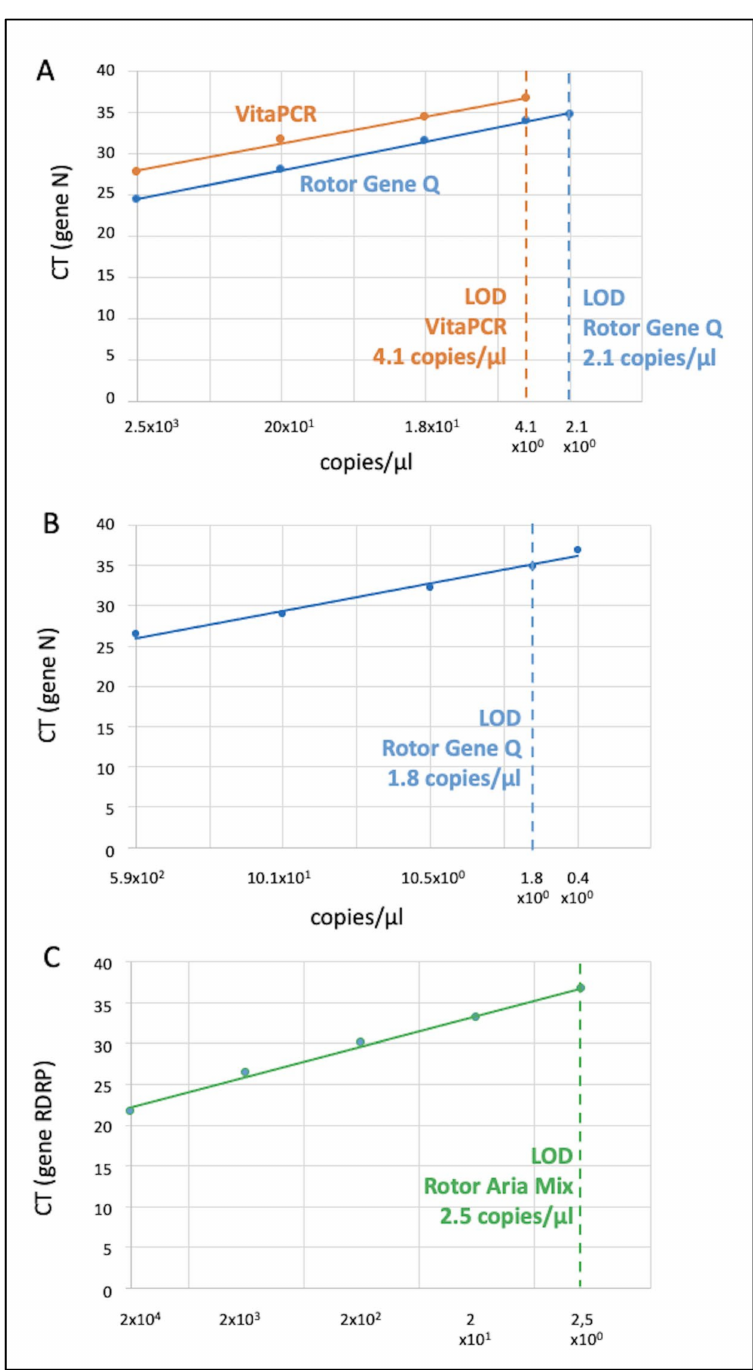
Figure 2. Limit of detection of the VitaPCR™, the Rotor Gene Q and the Aria Mix. The figure represents the LoD of ( A ) the VitaPCR™ and the Rotor Gene Q (Gene N) by the analysis of the Menarini Positive Control sample (and the same diluted samples); ( B ) the Rotor Gene Q (Gene N) via the analysis of the Sacace RT-PCR Positive Control sample; ( C ) the Aria Mix RT-PCR System (Gene RDRP) via the analysis of the Real Quality 129 Positive Control sample. Data of RNA copies/ µ L were log-converted (only for the figure) to obtain a linear